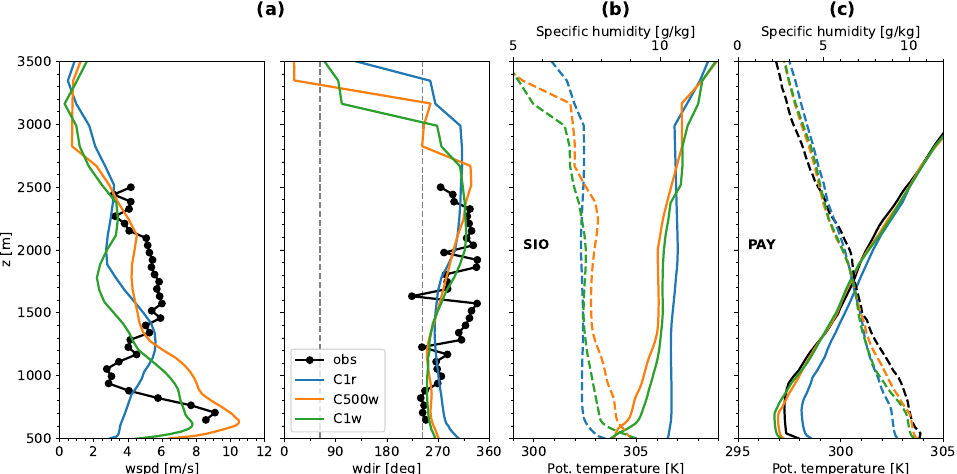
Figure 13. Structure of the valley atmosphere at Sion for 10 September 2016 at 16:00: ( a ) wind speed and wind direction; ( b ) potential temperature (solid lines) and specific humidity (dashed lines); ( c ) evaluation of the mean temperature and moisture structure at Payerne at 12 UTC, average over the 18 valley wind days. The grey dashed lines in the panel showing wind direction indicate the up- and down-valley direction,